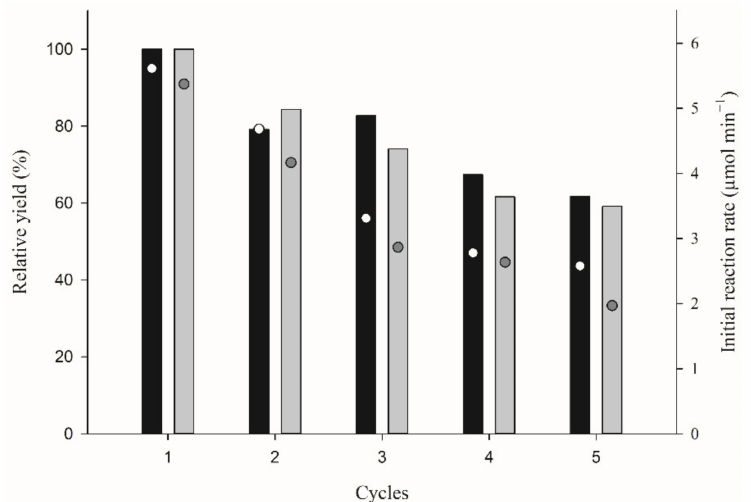
Figure 5. Relative yield (%) of consecutive isoamyl butyrate esterification cycles with butyric acid and commercial isoamyl alcohol (black) or isoamyl alcohol contained in fusel oil (light grey) as substrate. The yield for the first cycle was taken to be 100%. Initial esterification rate of butyric acid by commercial isoamyl alcohol (white circles) or isoamyl alcohol contained in fusel oil (grey